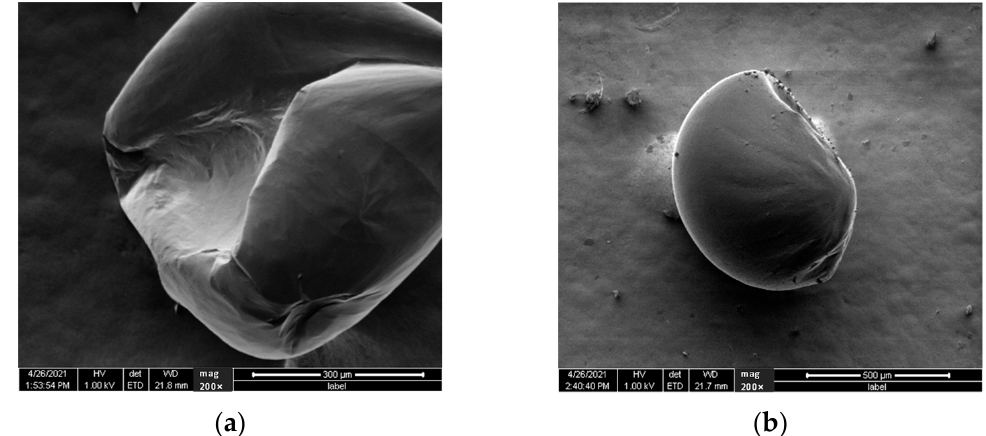
Figure 4. Images of dried PEG6000 particles under the scanning electron microscope (SEM) show the evolved particle structure at the end of the drying process. ( a ) T = 50 °C, 10% ( w / w ) and ( b ) T = 30 °C, 15% ( w / w ).